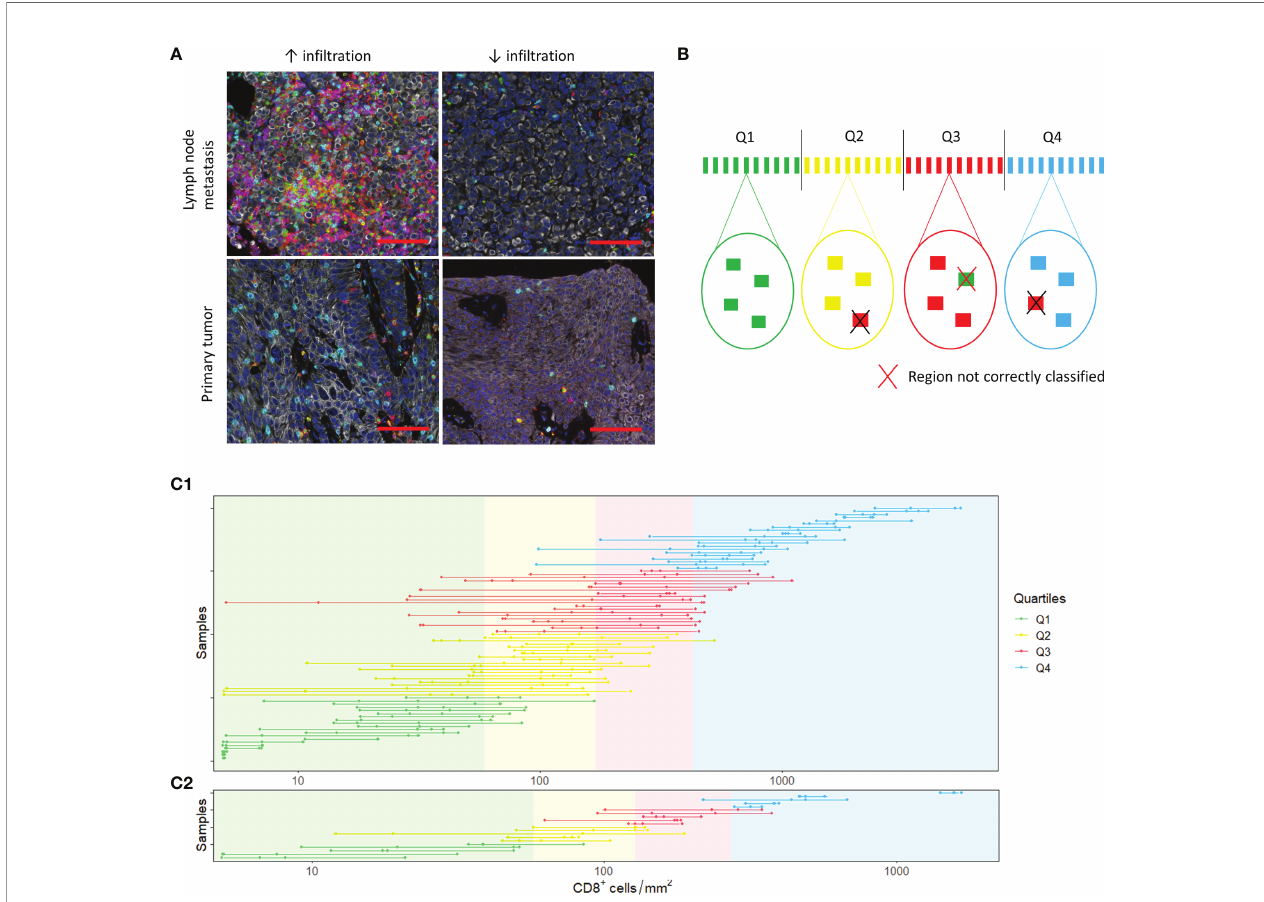
FIGURE 4 | Spatial heterogeneity. (A) Spatial heterogeneity in a lymph node metastasis (upper panel) and a primary tumor (lower panel). Images on the right and left side are derived from the same sample. The scalebar represents a distance of 100 µm. (B) Analysis of heterogeneity. In each sample, four tumor regions were selected. The mean cell density of these four regions was calculated. Based on the mean cell densities of the samples, quartiles were de fi ned (upper part of the fi gure). Next, we evaluated whether the small regions were representative by checking whether the individual regions belonged to the same quartiles as the sample mean. (C) CD8 + T cell densities in the selected 0.28 mm2 (C1) and 3.30 mm 2 (C2) regions. The dots show the cell densities of the regions. The four regions of one sample are interconnected by a line. In some regions, no CD8 + cells were present. To enable visualization of cell densities on a log scale, the CD8 + densities of these patients was replaced by 5 cells/mm2 (~lowest value in C1 and